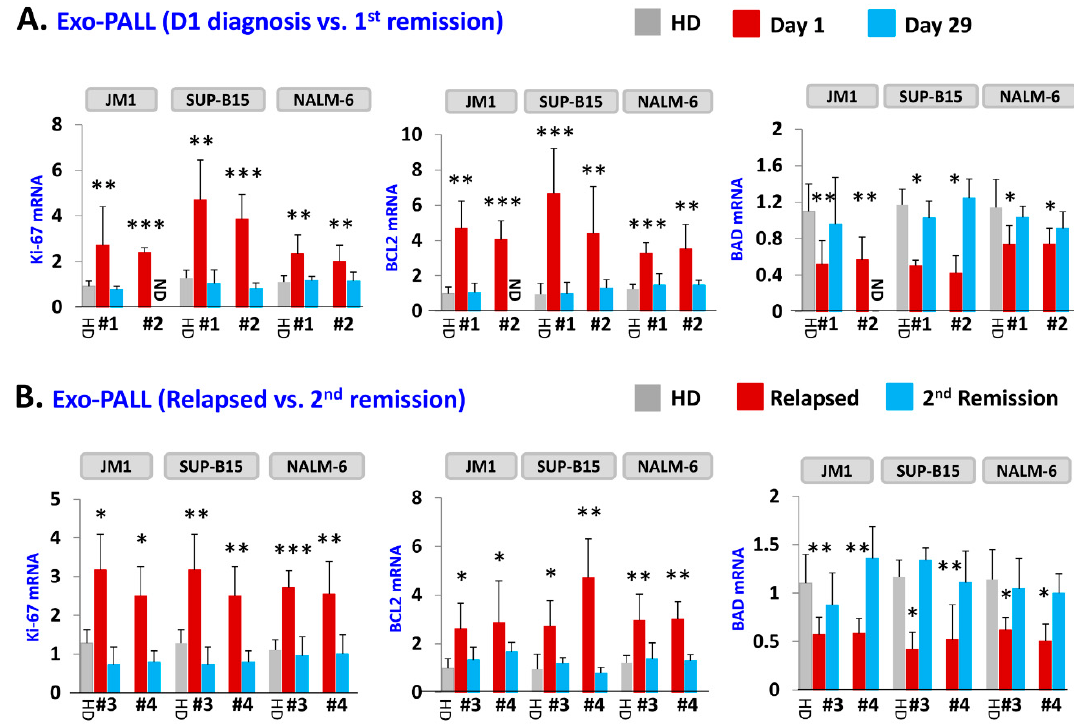
Figure 4. Exo-PALL treatment contributes to gene regulation in leukemia cell lines which correlates with disease stage. Three di ff erent cell lines were exposed with indicated Exo-PALL isolated from serum of Pt #1 (Day1 diagnosis), Pt #2 (Day29 1st remission), Pt #3 (first relapse) and Pt #4 (2nd remission). The expression of mRNA was evaluated by q-PCR. ( A ) Exo-PALL Pt #1 up-regulates Ki-67 and BCL2 mRNA expression and down-regulate BAD mRNA expression in JM1, SUP-B15 and NALM-6 leukemia cell lines compared to HD exosomes. This augmentation e ff ect of Exo-PALL on mRNA expression is no longer detectable during remission (Pt #2; Day 29-remission). ( B ) Similar e ff ect is obtained with Exo-PALL Pt #3 and #4 at first relapse and in 2nd remission. (Pt #1, #2, #3 and #4: Exo-serum samples of four di ff erent patients. HD: healthy donor control serum). ( p -value * p < 0.05, ** p < 0.01, *** p < 0.001).